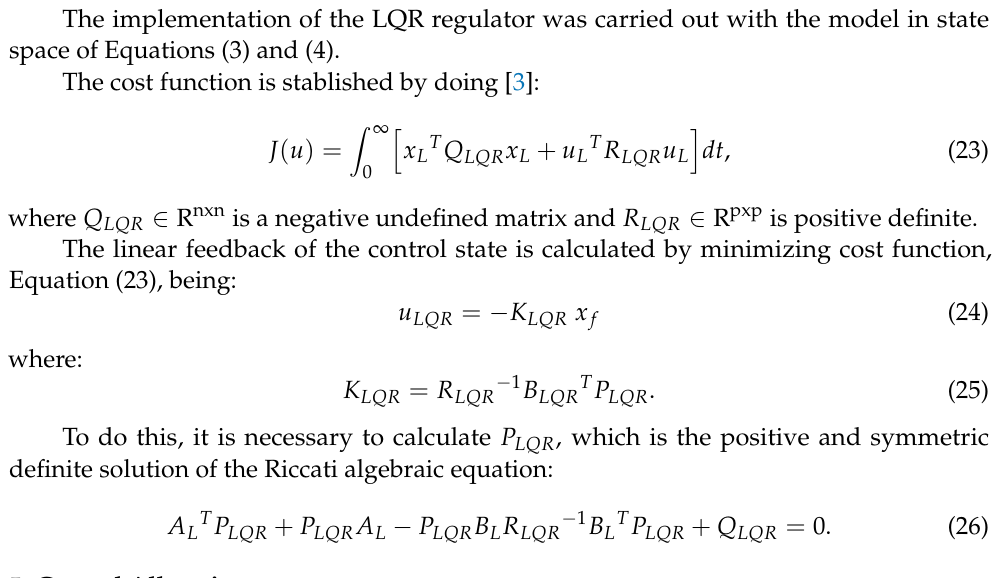
Figure 4. LQG control strategy for three degrees of freedom x, y and ψ .